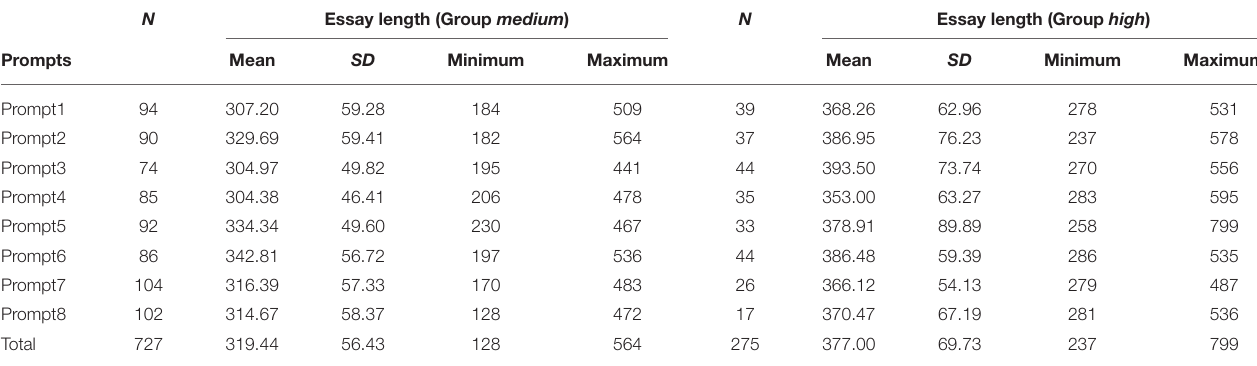
TABLE 1 | Distribution and descriptive statistics of the selected essays. N Essay length (Group medium ) N Essay length (Group high )